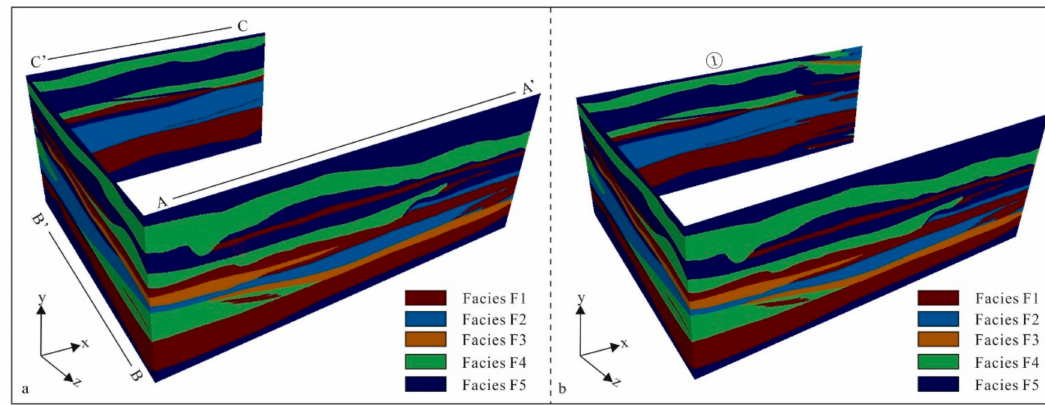
Figure 5. Three two-dimensional training images. ( a ) Illustrates the original digital outcrops; ( b ) the result of one executed two-dimensional simulation, and provides the basic data required to generate the three-dimensional models. Deep red, blue, orange, green, and violet are facies F1, F2, F3, F4, and F5,